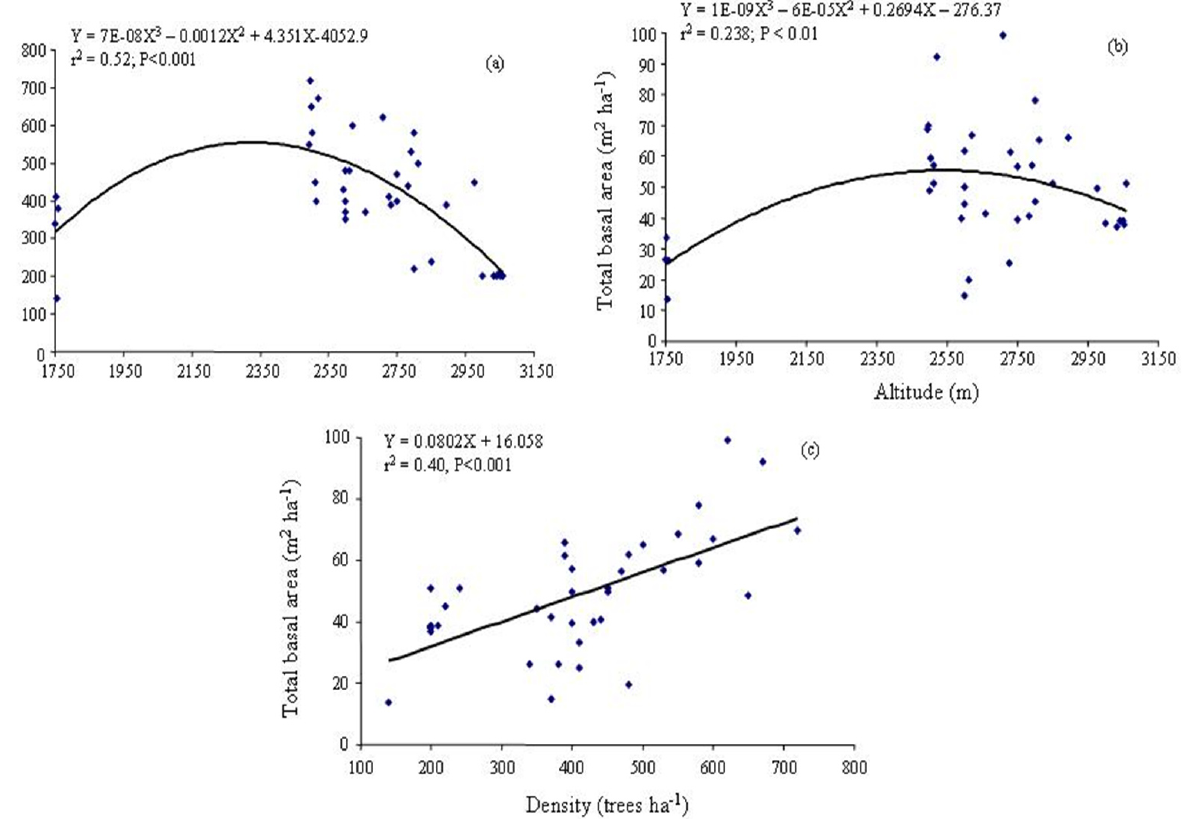
Fig. 4. Relationships between density, total basal area with altitude and total basal area with density in the study